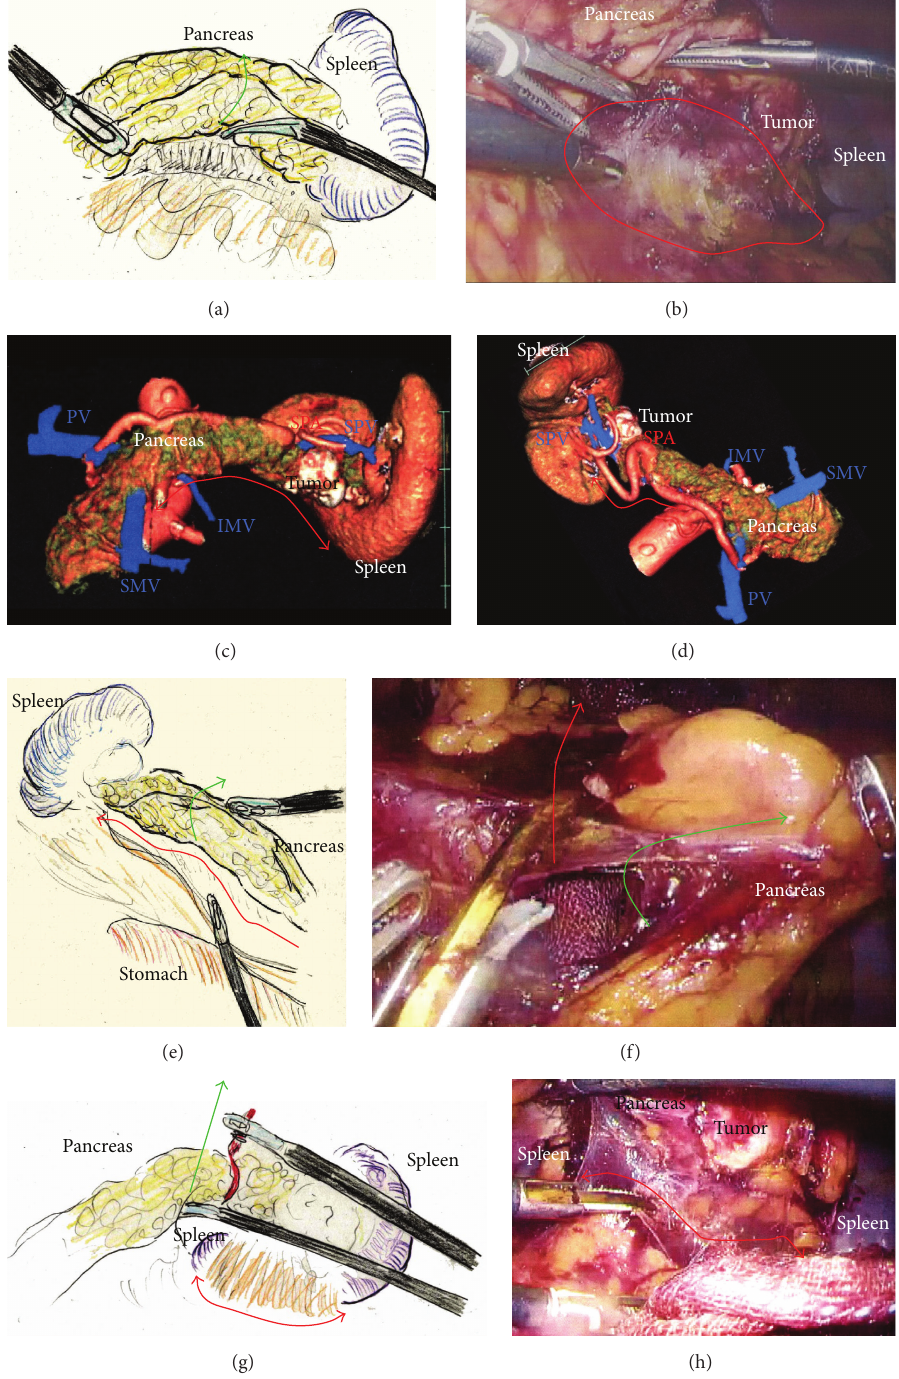
Figure 2: (a) The pancreas was retracted during a dorsal approach (green arrow). (b) During the dorsal approach, the distal pancreas was securely mobilized by dissecting the connective tissue (red circle). (c) Removal of the pancreas by a dorsal approach was simulated preoperatively (red arrow). (d) Removal of the pancreas by a ventral approach was also simulated preoperatively (red arrow). (e) and (f) The pancreas was retracted (green arrow) and then a ventral approach was recommended to complete the removal of the pancreas (red arrow). (g) and (h) The pancreas was retracted using the forceps shaft and/or tape (green arrow). Next, connective tissue and the thin membrane surrounding the spleen were cut using a dorsal approach (red arrow). The distal pancreas and spleen were then completely